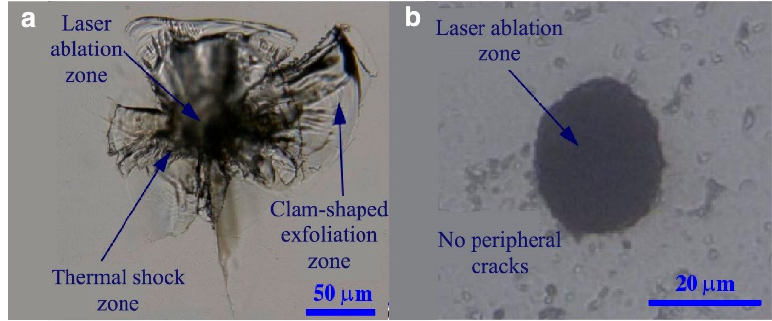
Figure 20. Typical morphological comparison of the laser damage sites on KDP crystal surfaces induced by short and ultra-short laser pulses. ( a ) FWHM (Full Wave at Half Maximum) = 6.9 ns; ( b ) FWHM = 28 fs [29].